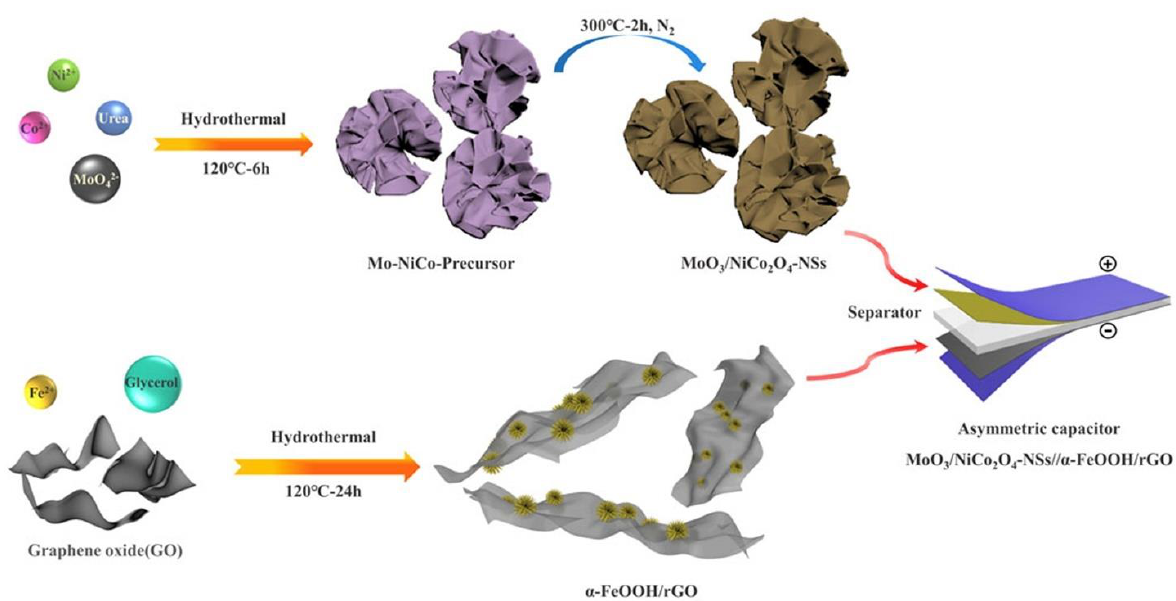
Figure 17. Schematic of MoO 3 /NiCo 2 O 4 - NSs, α -FeOOH/rGO synthesis (hydrothermal) process, and asymmetric supercapacitor. Reprinted with permission from [157]. Copyright 2019 Elsevier.